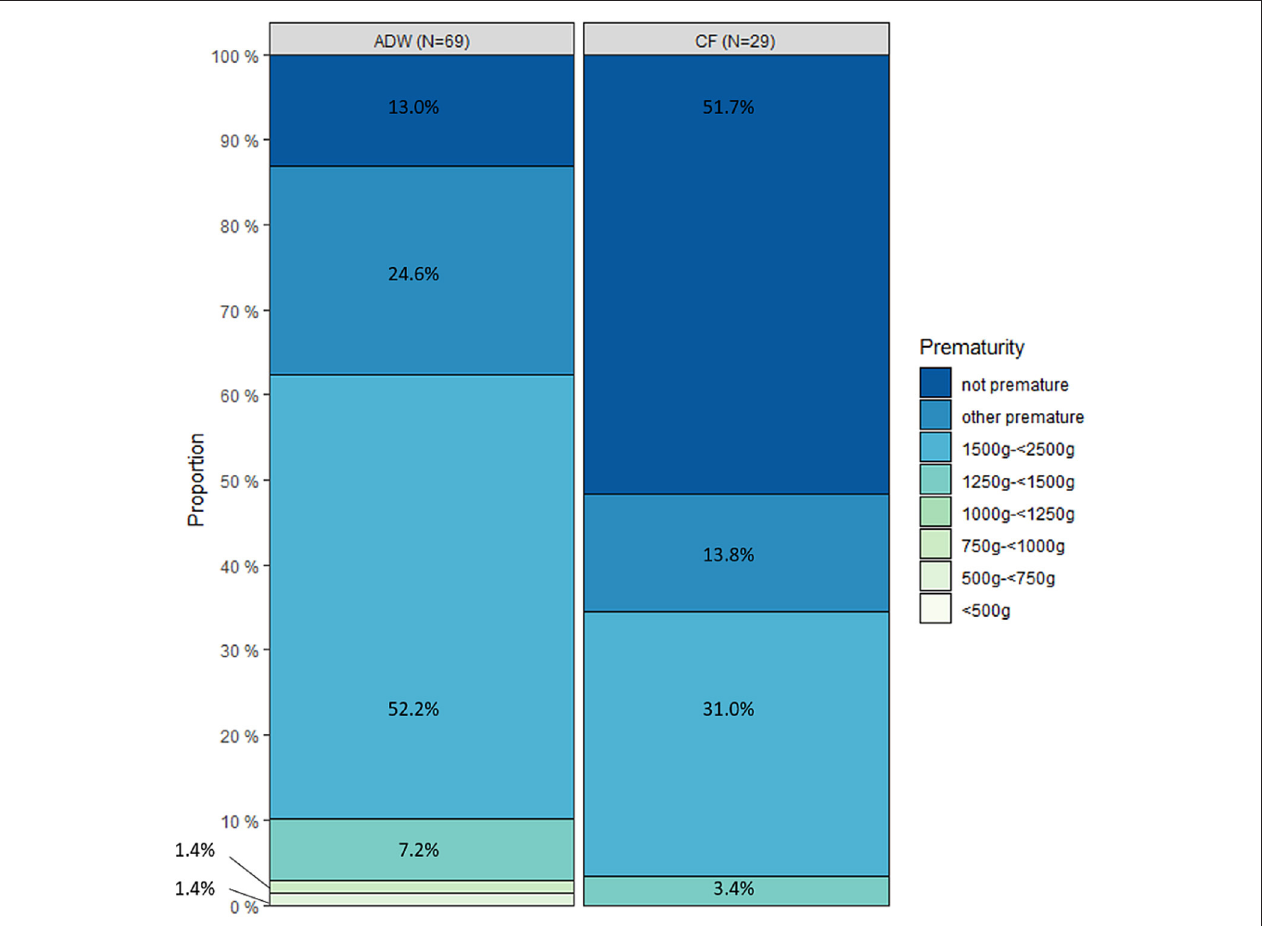
FIGURE 2 | Distribution of patients with abdominal wall defect (AWD) ( n = 69) and cystic fibrosis (CF) ( n = 29) regarding pre-maturity.